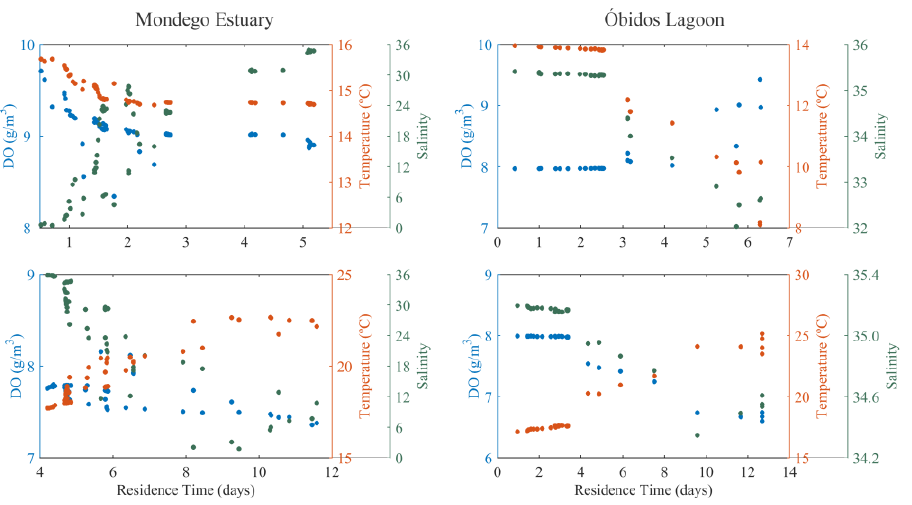
Figure 12. The relation between water temperature (°C), DO (g/m 3 ) and salinity with residence time for Mondego estuary (left) and Ó bidos Lagoon (right), for winter (top) and summer